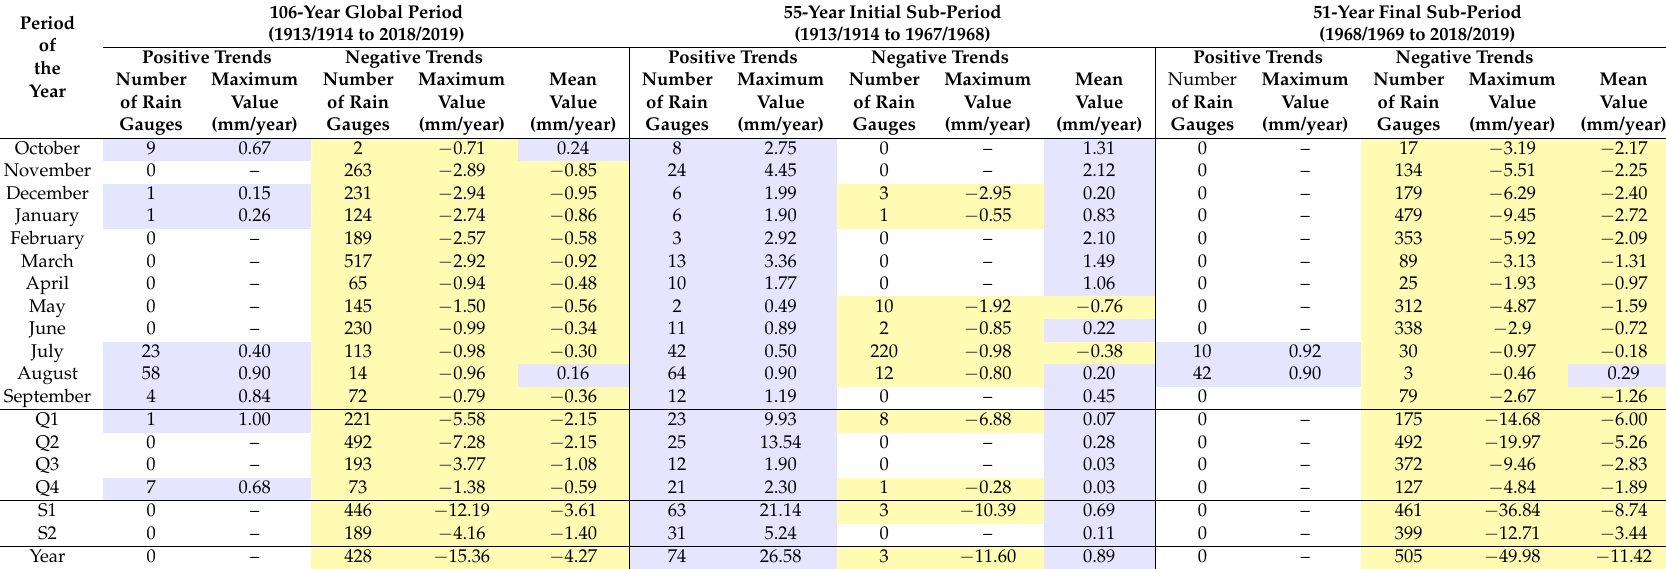
Table 1. Summary of the significant trends for the 106-year period and for its initial 55 years and final 51 years. Number of rain gauges with significant trends. Maximum (positive), minimum (negative) and average values of the Sen’s slope estimates for the significant increasing (in blue) and decreasing (in yellow) trends,